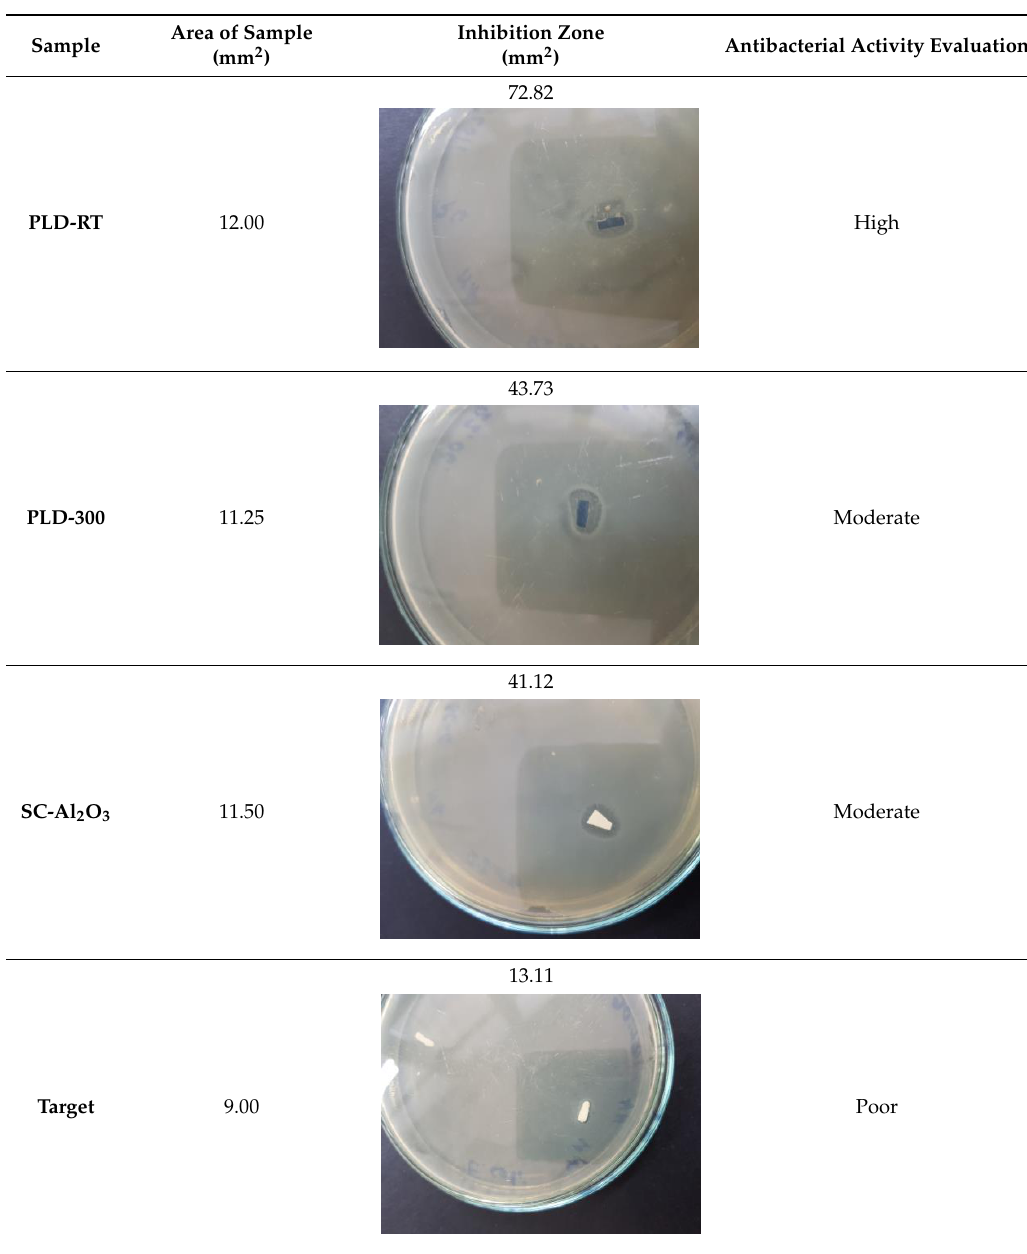
Table 4. Details of antibacterial activity evaluation.